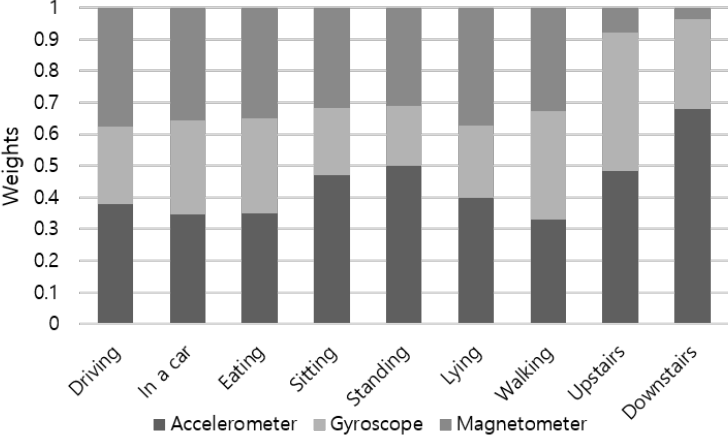
Figure 12. Proportion of weights of each sensor is computed based on the recognition